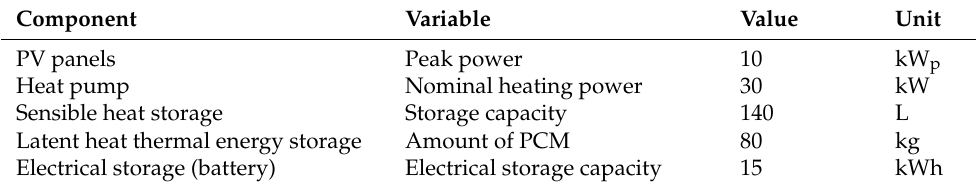
Table 2. Sizing of the main components of the innovative system.